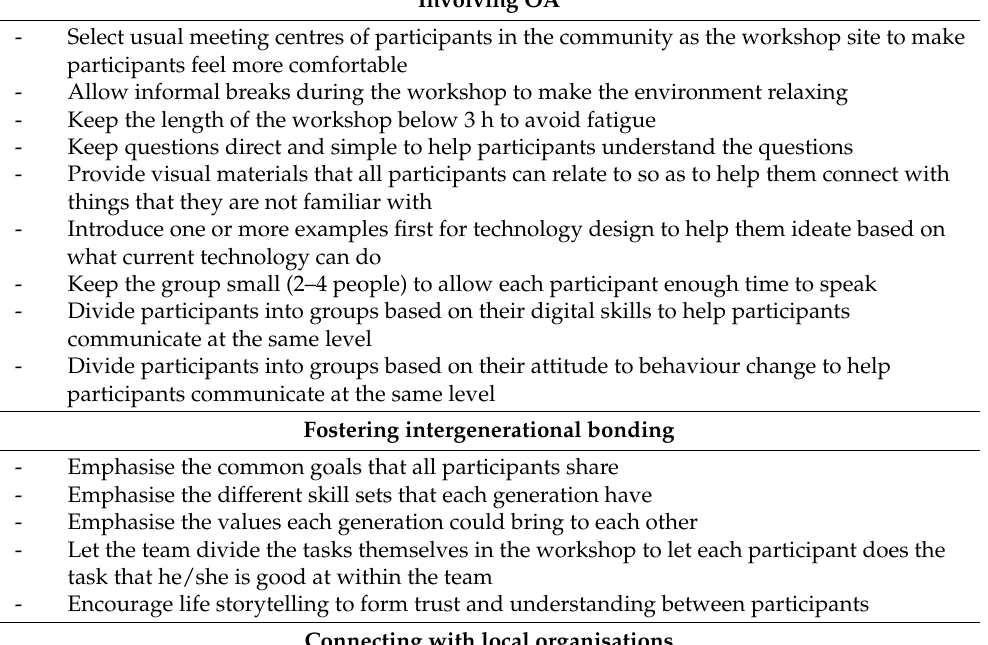
Table 3. Guidelines for co-designing with OA for community-based interventions. Involving